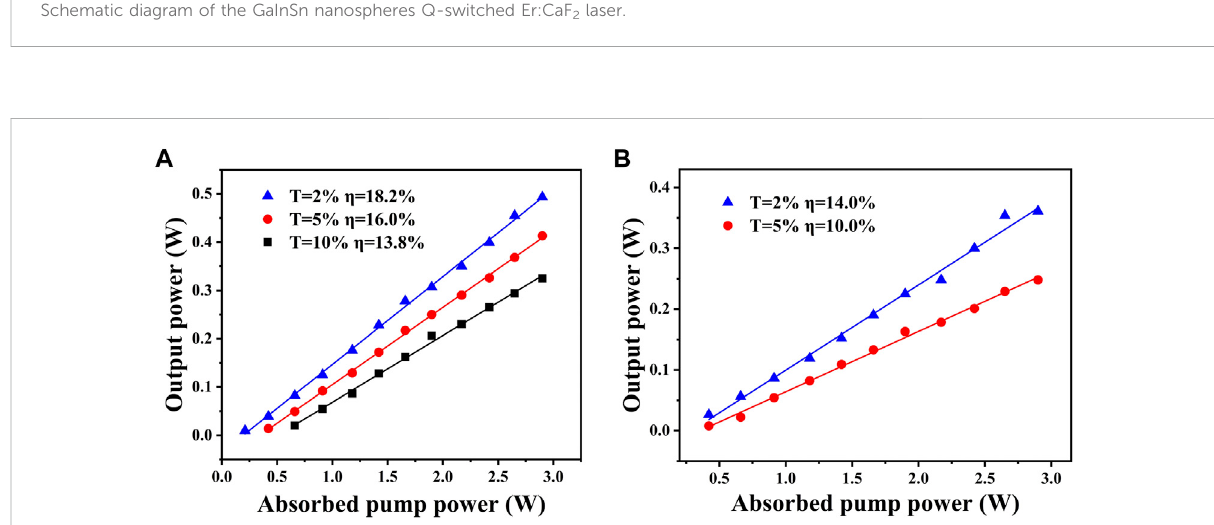
Schematic diagram of the GaInSn nanospheres Q-switched Er:CaF 2